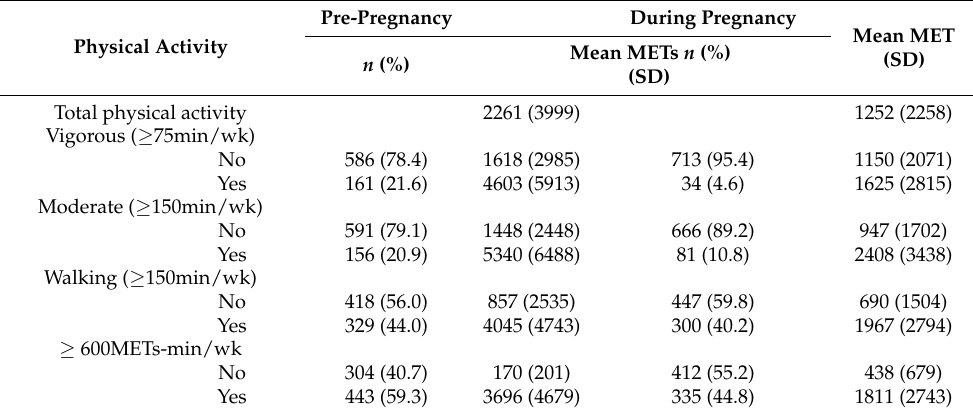
Table 2. Physical Activity Before and During Pregnancy ( N = 747).